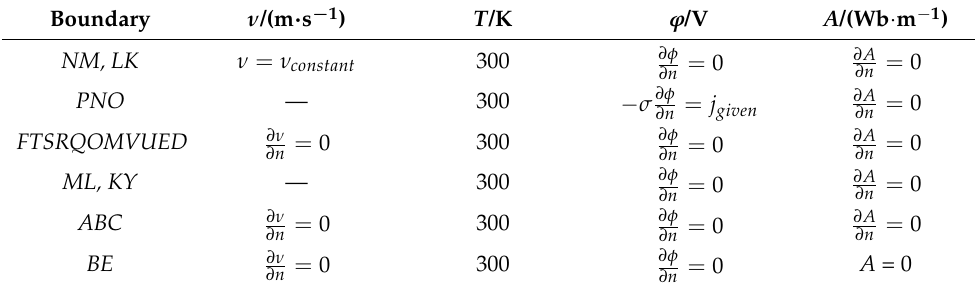
Table 2. Boundary